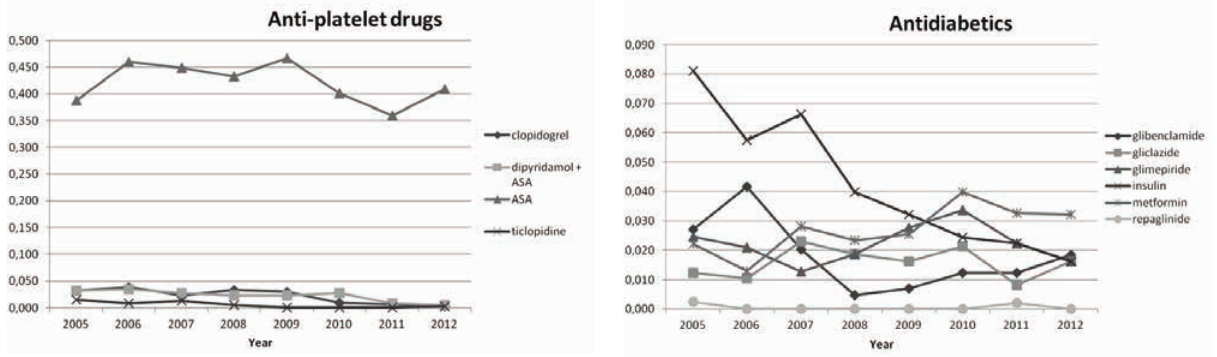
Figure 1: The predominant position of acetylsalicylic acid (ASA) among antiplatelet drugs is connected with a significant decrease in use of all other antiplatelet agents. This trend was caused by changes in guidelines for an antiplatelet therapy of cerebrovascular diseases at the beginning of monitored period.